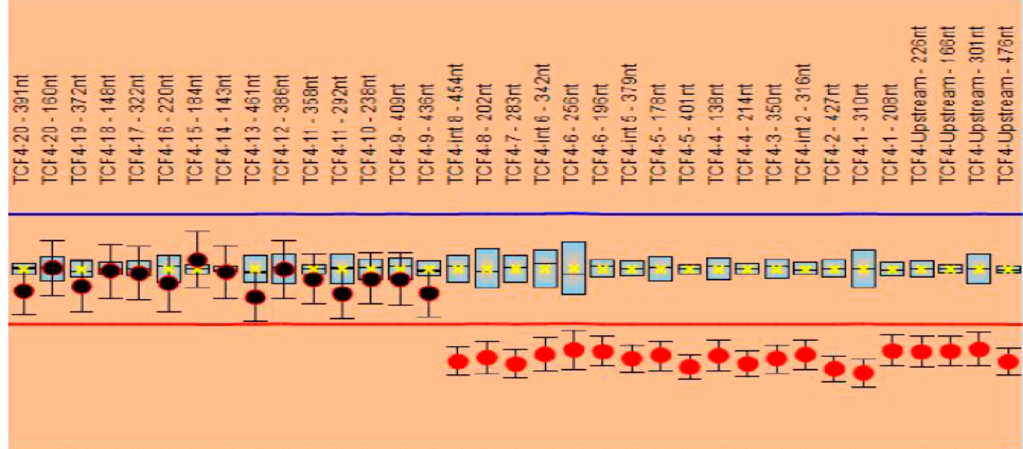
Figure 2. Salsa MLPA P075 results. Heterozygous deletion of exons 1 to 8 and normal ranges for exons 9 to 20.